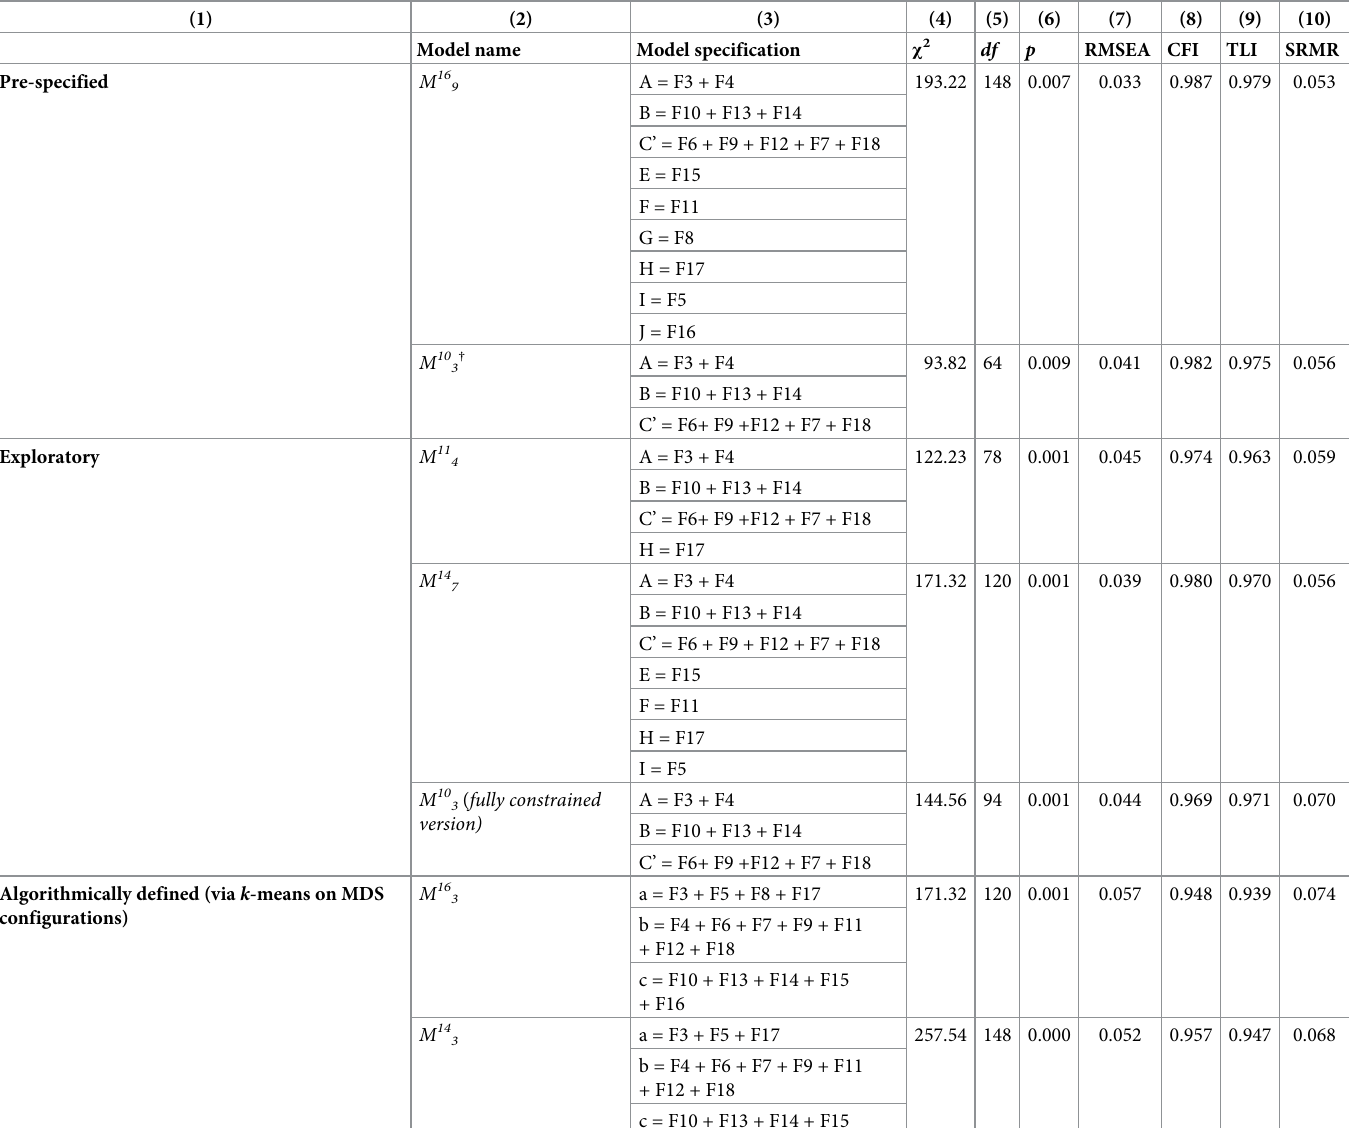
Table 5. The estimated models from CFA.